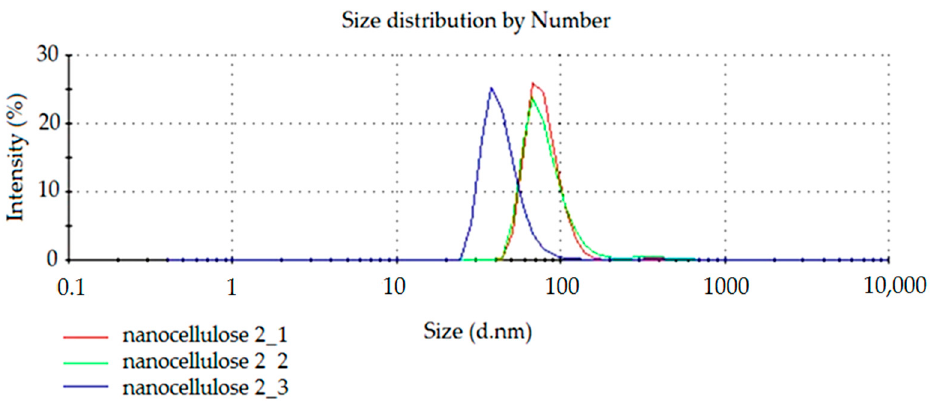
Figure 3. The spectrum of dependence of particle intensity on particle size.